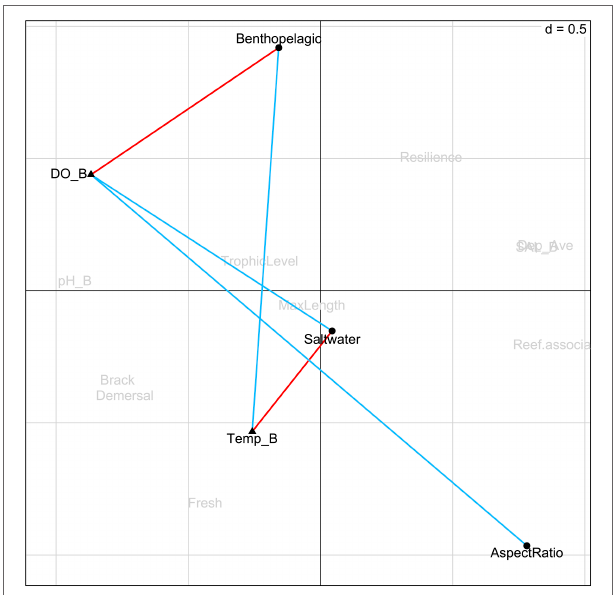
FIGURE 3 | Biplot of the fish traits and environmental variables from the RLQ analysis. The significant positive correlations between fish traits and environmental variables are represented by red cells and negative ones by blue cells, which are obtained from the multiple testing using the FDR (false discovery rate) procedure with the α = 0.05 level. DO_B is the DO in the bottom water; Temp_D is the temperature in the bottom water; Benthopelagic is the trait of species for water column position; Saltwater is the trait of species of salinity preference; AspectRatio is the trait of species of the aspect ratio of the caudal fin. See Table S6 for acronyms of traits.